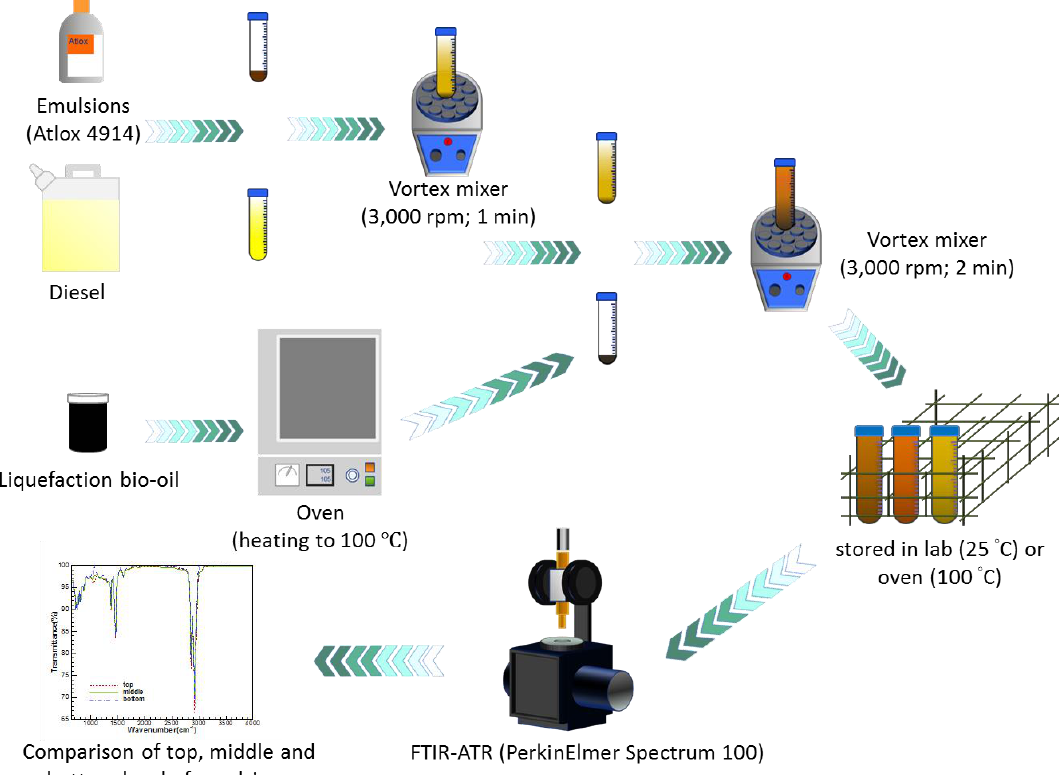
Figure 1. Scheme of emulsion preparation and stability analysis.